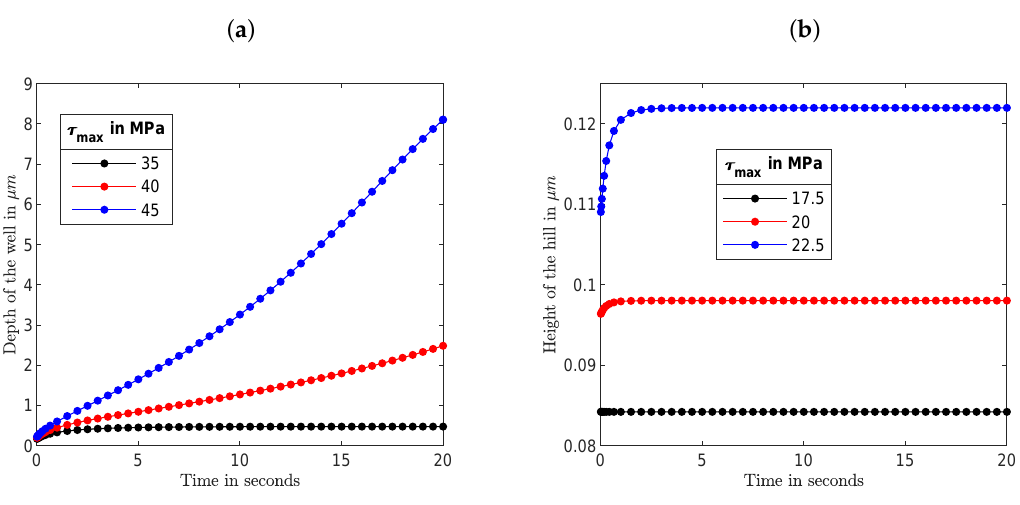
Figure 6. Time-dependent deformations in z direction for light polarized ( a ) in x direction and ( b ) in y direction at different values of maximal traction shown in the legend. The beam radius w = 2